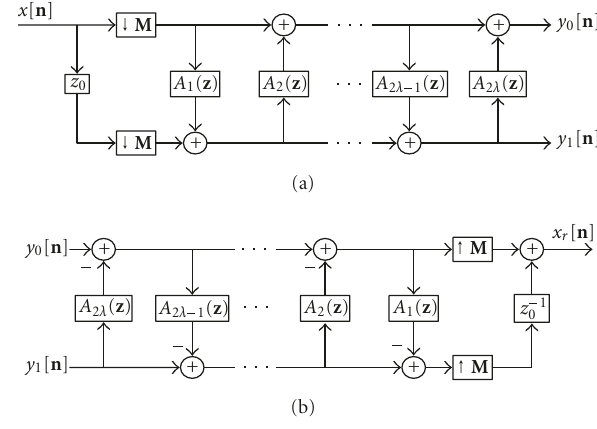
Figure 4: Lifting realization of a quincunx filter bank: (a) analysis side, and (b) synthesis